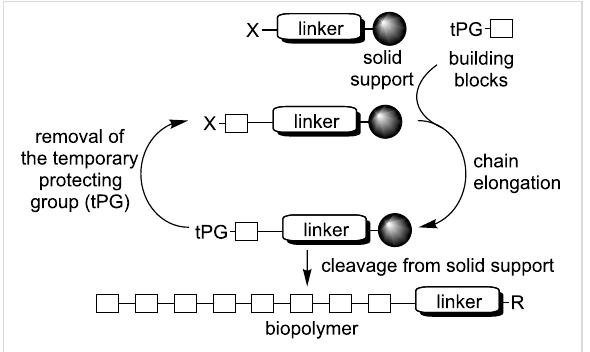
Scheme 1: Solid-phase synthesis of biopolymers. X represents a reac- tive site such as an amino group for peptide synthesis or a hydroxy group for oligonucleotide and oligosaccharide